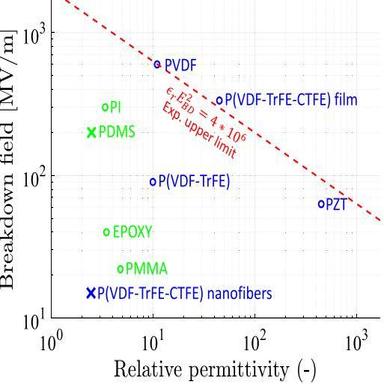
Breakdown voltage versus relative permittivity for selected ferroelectric polymeric and ceramic materials, as retrieved from, from and for the PZT, from for the PVDF, from and for the PVDF-TrFE.